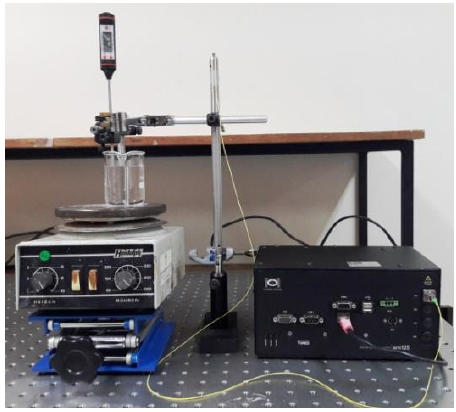
Figure 2. Photograph of the experimental setup for agarose deposition.